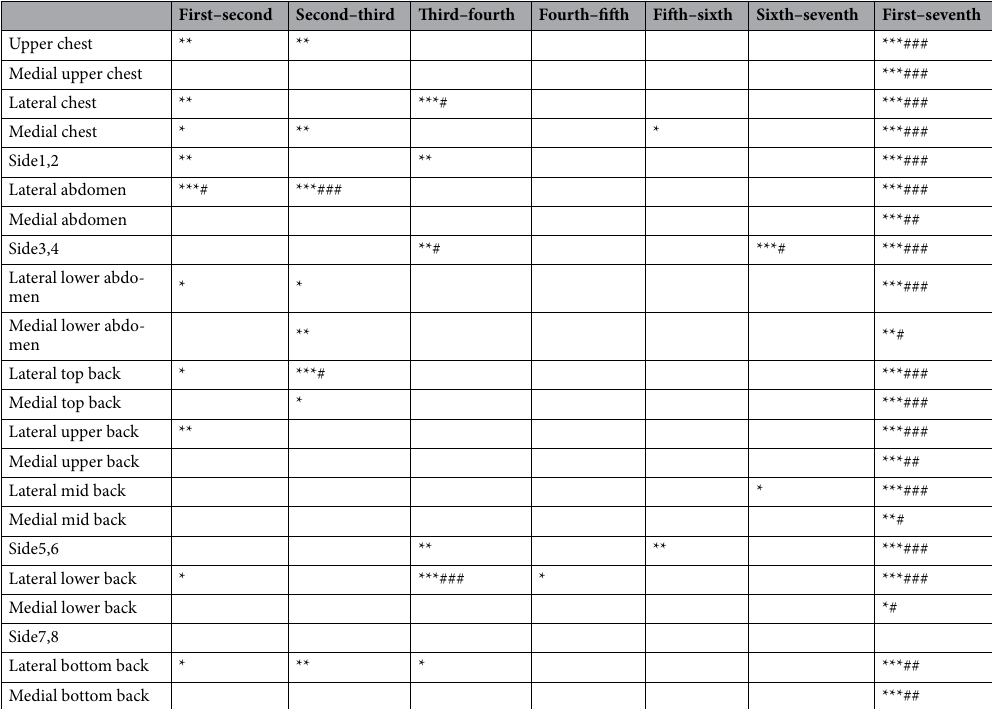
Table 2. A one-way measure ANOVA was performed to analyze regional sweat rate differences before and after sweat profile presented using Bonferroni correction for post hoc comparisons. The significance level was accepted at P < 0.05. we performed statistical analysis using IBM SPSS (https:// www. ibm. com/ cn- zh/ analy tics/ spss- stati stics- softw are). Significance levels of comparison of pre- versus post-set absolute regional sweat rates values. Significance level for uncorrected data: * P < = 0.05; ** p < = 0.01, *** p < = 0.001; Significance level following Bonferroni correction: # P < = 0.05; ## p < = 0.01; ### p < =